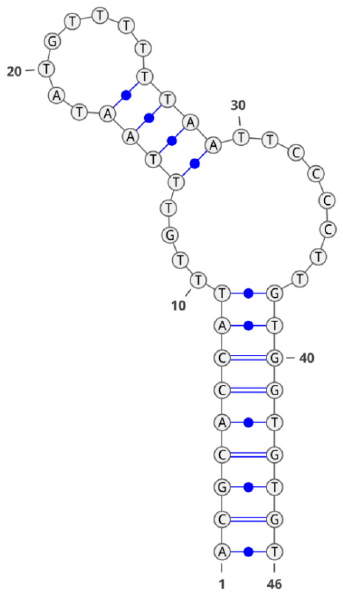
Figure 5. Secondary structure of the GR20 aptamer.